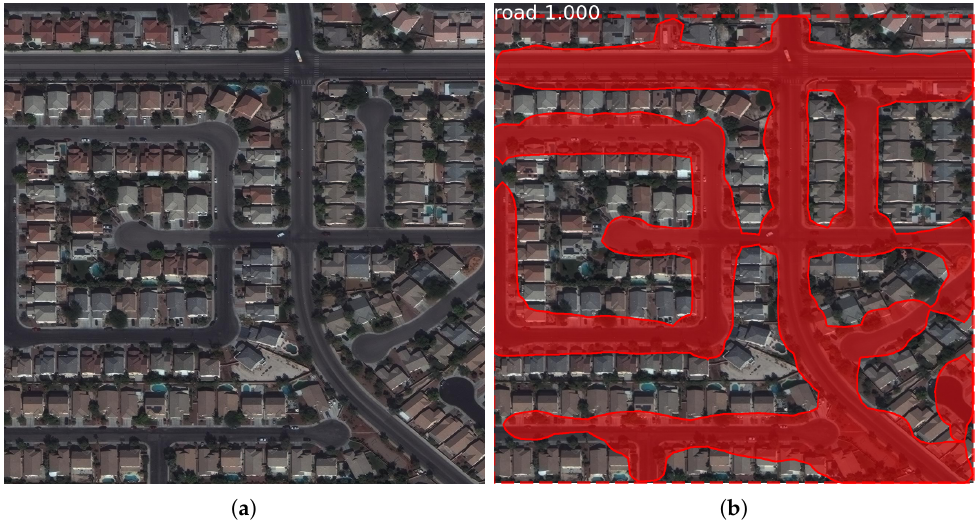
Figure 12. Mask R-CNN results: ( a ) Unaltered residential satellite image over streets of Las Vegas, Nevada; ( b ) sample of Mask R-CNN results over ( a ) Las Vegas image.